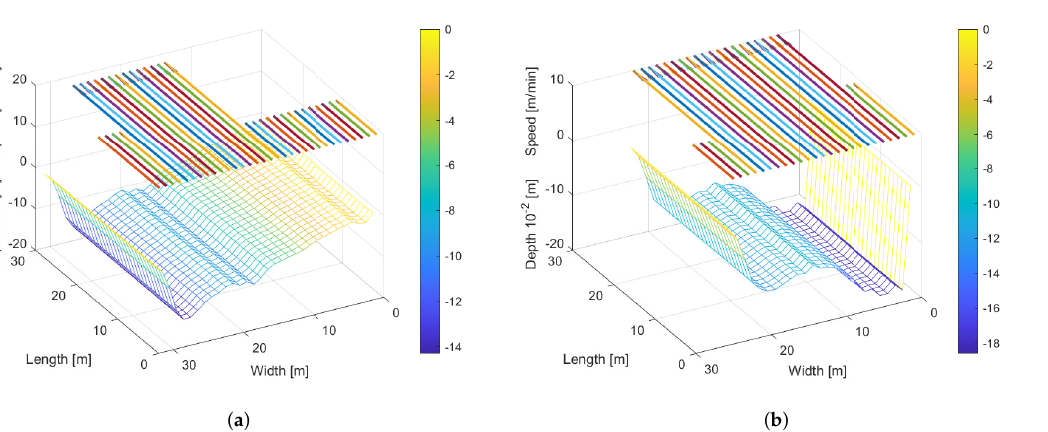
Figure 2. Cross–section of the riverbed and current velocities—Lutoryz ( a ) and Smolarzyny ( b